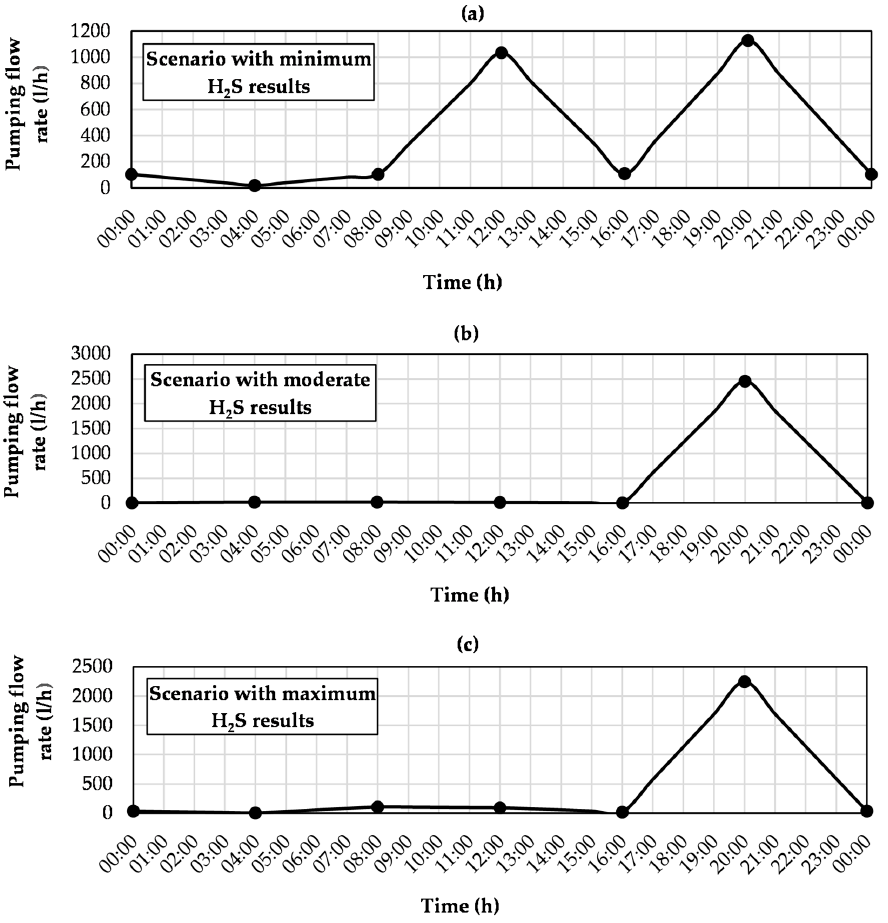
Figure 17. Pumping schedules obtained through genetic algorithm optimization with respect to three different loading scenarios. ( a ) The first panel shows the pumping schedule concerning the loading scenario with minimum H 2 S production results; ( b ) The second panel depicts the pumping schedule for a loading scenario with moderate H 2 S production results; ( c ) The third panel shows the pumping schedule for the loading scenario with maximum H 2 S production results in the network nodes.